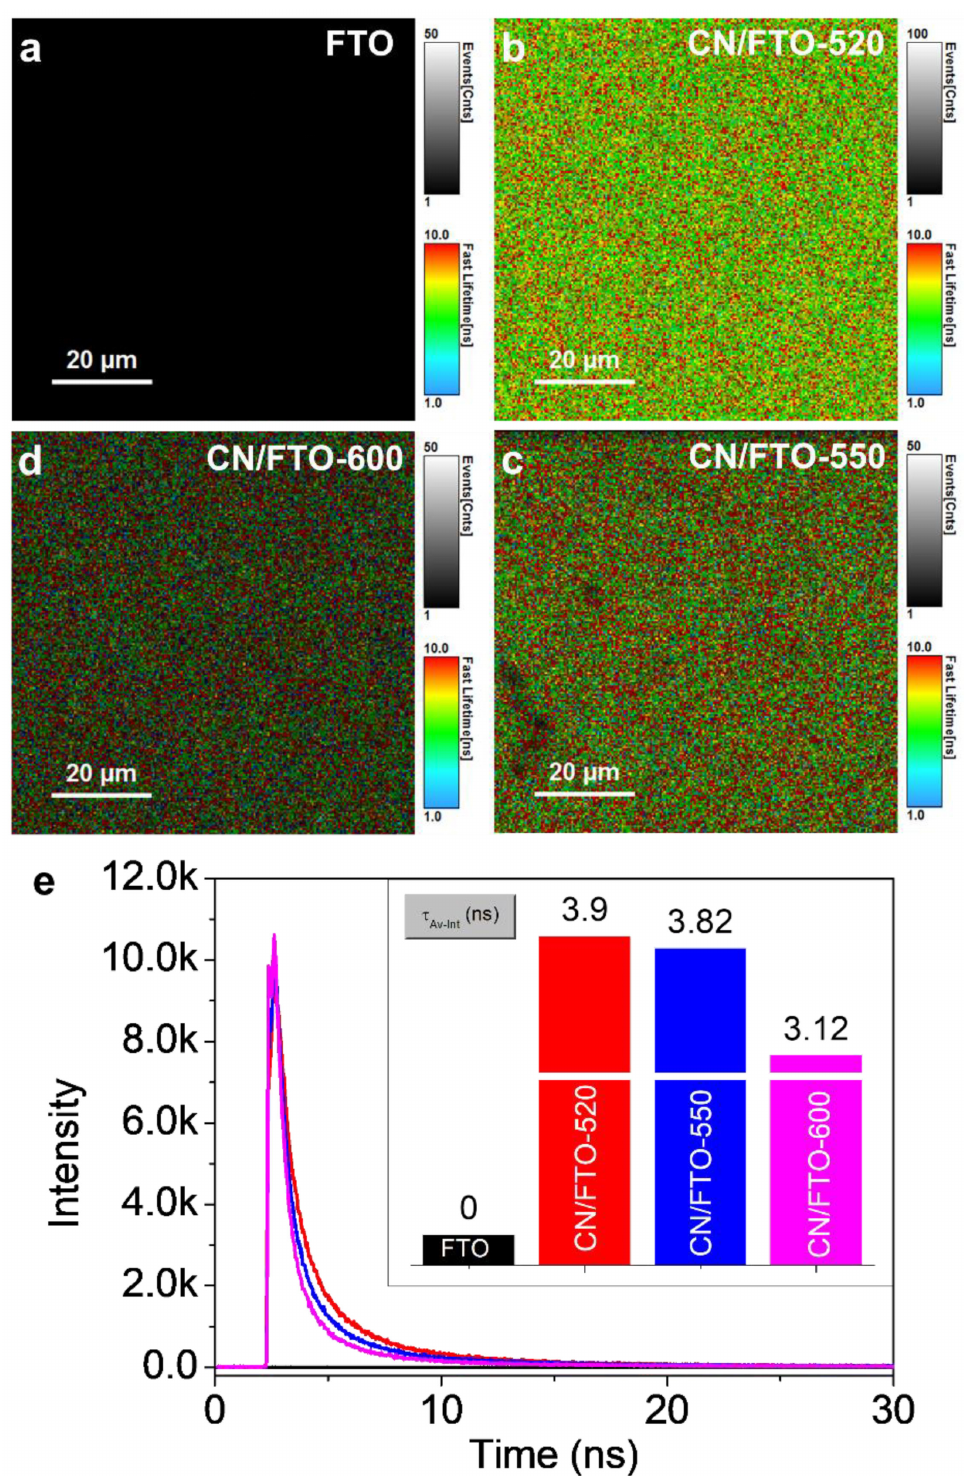
Figure 6. Time-resolved photoluminescence (TRPL) images of ( a ) bare FTO, ( b ) CN/FTO-520, ( c ) CN/FTO-550, ( d ) CN/FTO-600 films and ( e ) their decay curves. Inset of ( e ) are the corresponding intensity-weighted average lifetimes of different